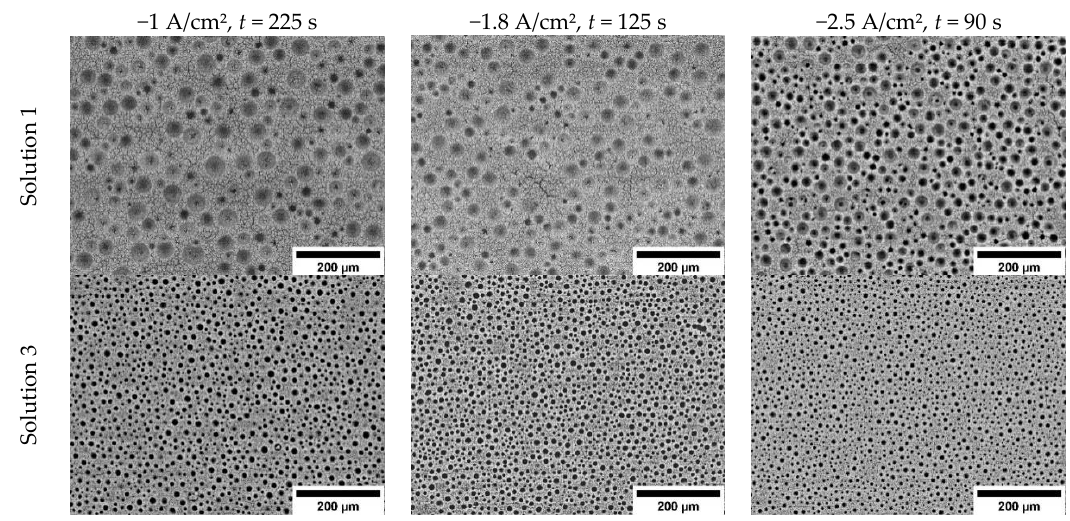
Figure 2. Scanning Electron Microscopy images of cobalt coatings obtained under a galvanostatic mode at various deposition conditions, but the same value of charge passed ( q = 180 C).